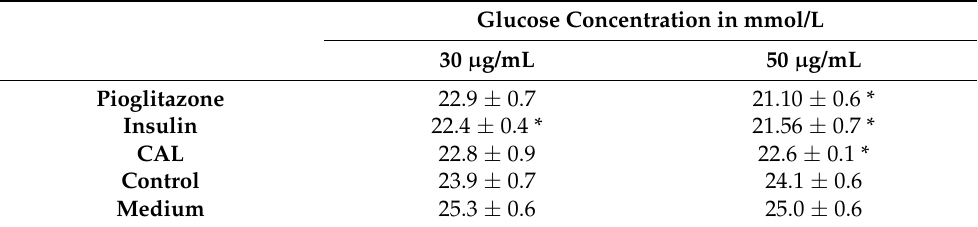
Table 5. Effect of C. aethiopica leaf total methanol extract (CAL) at concentrations of 30 and 50 µ g/mL on glucose consumption in media of 3T3-L1 adipocyte